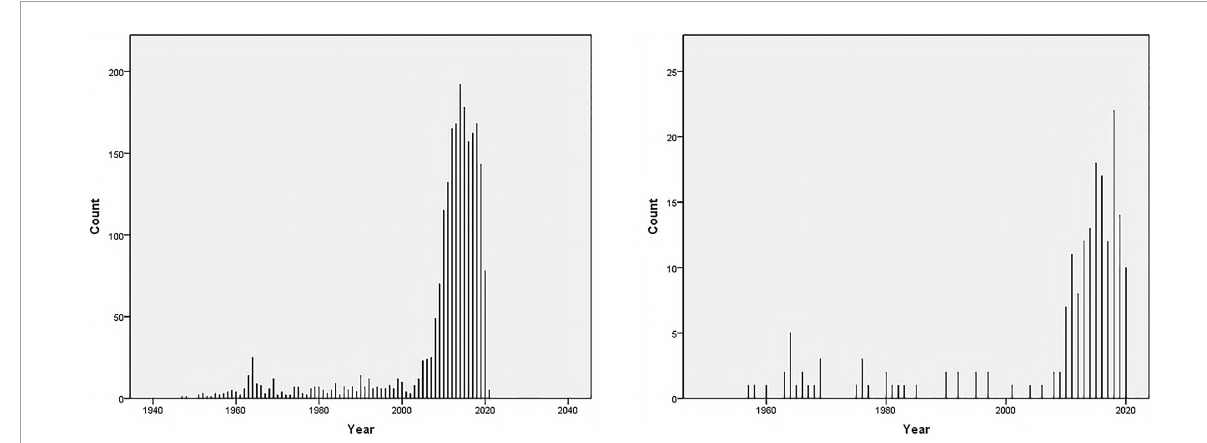
FIGURE2 Number of publications on “vitamin D AND cardiovascular disease” in the PubMed database as of December 2020. (A) Vitamin D [MeSH Major Topic] AND cardiovascular disease [MeSH Major Topic]. (B) Vitamin D [MeSH Major Topic] AND cardiovascular disease [MeSH Major Topic], “Child: birth-18 years” [MeSH Terms] OR “Newborn: birth-1 month” [MeSH Terms] OR “Infant: birth-23 months” [MeSH Terms] OR “Infant: 1–23 months” [MeSH Terms] OR “Preschool Child: 2–5 years” [MeSH Terms] OR “Child: 6–12 years” [MeSH Terms] OR “Adolescent: 13–18 years” [MeSH